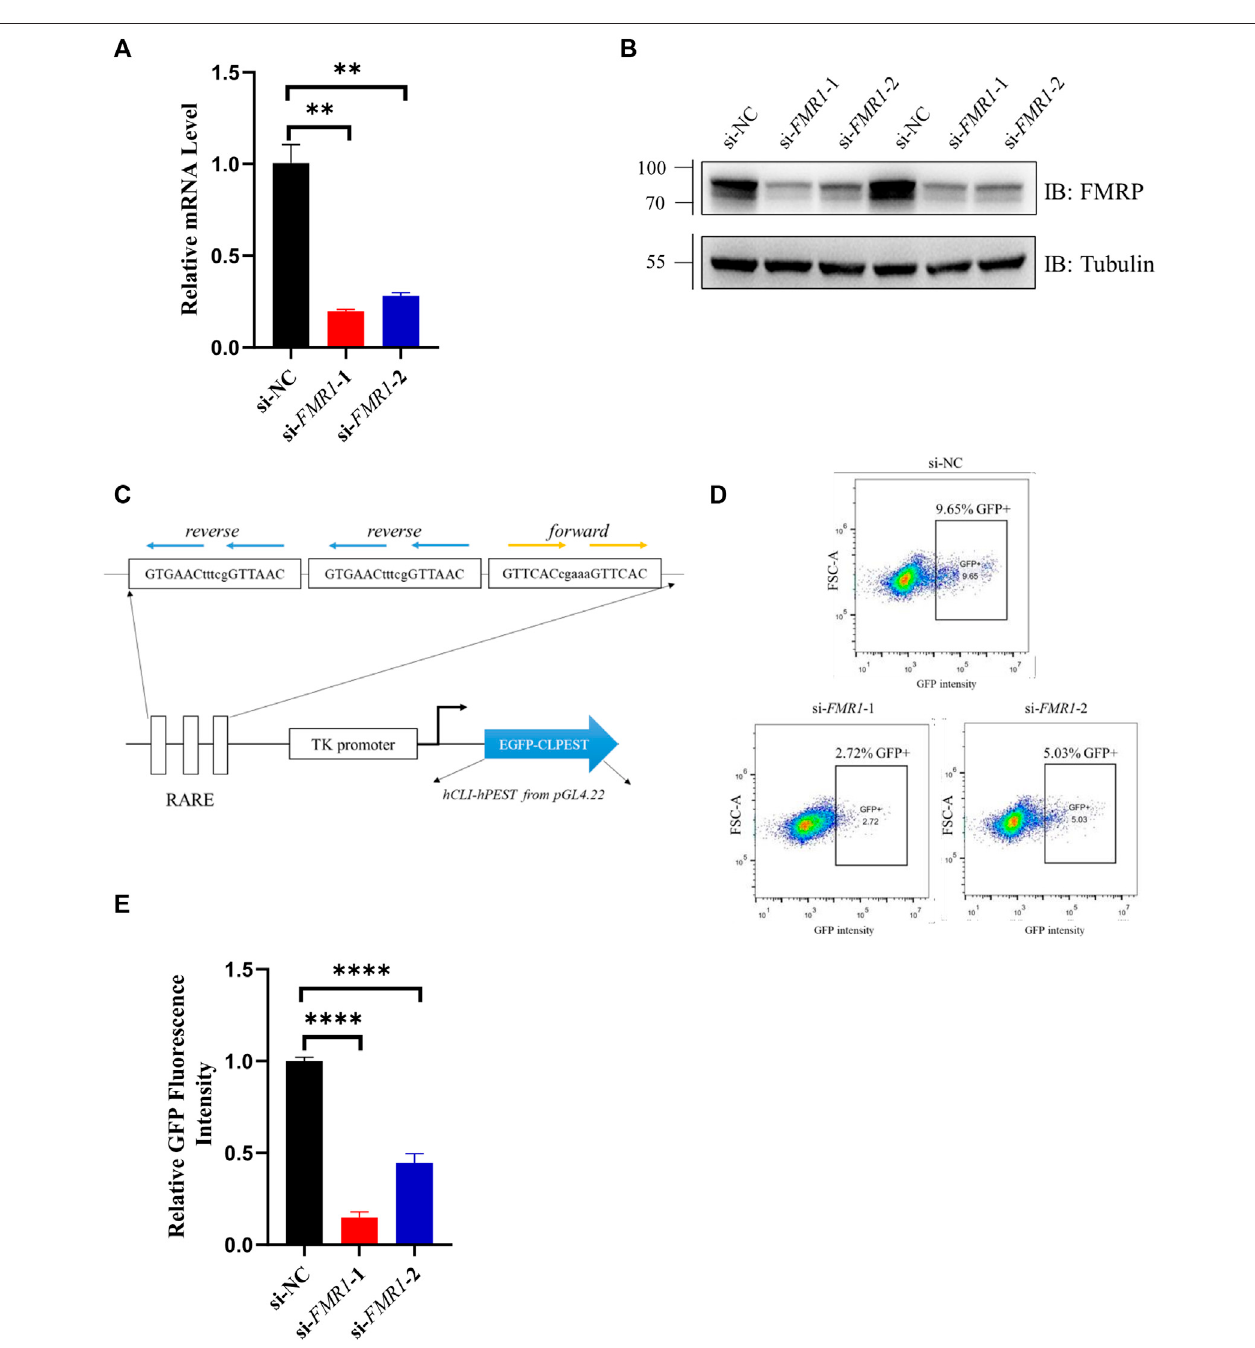
FIGURE1| RA-induced geneexpressionwasdown-regulatedin FMR1 knockdowncells. (A,B) Analysiswith (A) RT-qPCRand (B) Westernblottingfortheeffects of siRNAs on the expression level of FMR1 in SH-SY5Y cells. (C) Schematic diagram of 3×RARE-EGFP reporter construct. The expression of EGFP was regulated by three copies of RA-response element (RARE). CL1PEST sequence was attached to the C terminal of EGFP to promote its turnover. (D) Flow cytometry analysis of SH- SY5Y cells transfected with RARE-EGFP reporter and indicated siRNAs. The proportion of GFP positive (GFP+) cells were noted (E) . Quanti fi cation of normalized GFP fl uorescence intensity from fl ow cytometry analysis. n = 3 biological replicates. Data are presented as means ± SEM. ** p < 0.01, **** p < 0.0001. One-way ANOVA with Dunnett post hoc test.